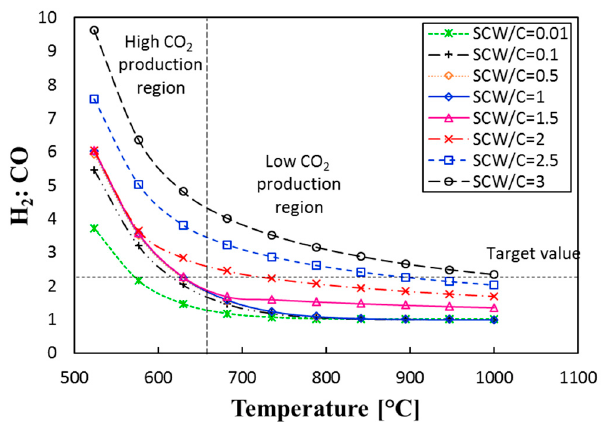
Figure 7. Variation of the syngas quality (H 2 :CO molar ratio) with temperature, for different values of the supercritical water to fuel ratio (SCW/C) in reactor R 1 . The target (shown in the figure) is to obtain the syngas quality (H 2 : CO molar ratio) value of ~2.1, suitable for the Fischer–Tropsch process and some fuel cell applications.